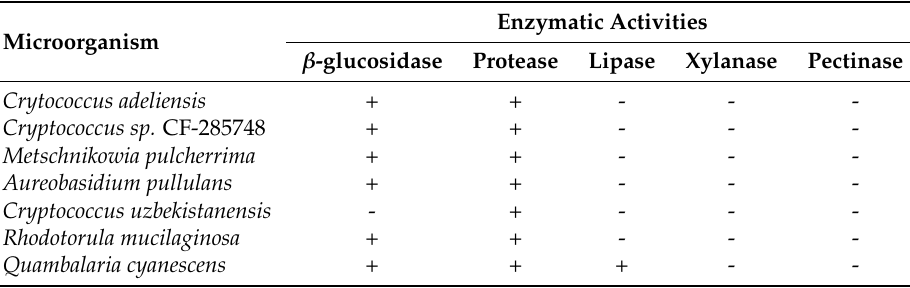
Table 5. Enzymatic characterization of the